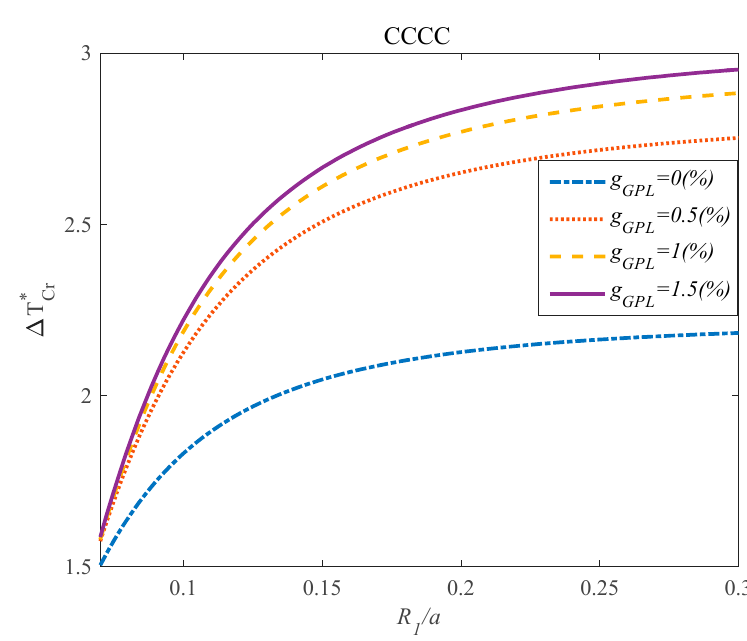
Figure 12. The e ff ects of g_GPL and R_1 / a on the critical temperature of a GPLRC panel for the CCCC Figure 12. The effects of g_GPL and R_1/a on the critical temperature of a GPLRC panel for the CCCC boundary conditions (b / a = 4, h = a / 10, NL = 10, R2 = 5b, µ = h / 10, l = h / 5, and boundary conditions (b/a = 4, h = a/10, NL = 10, R2 = 5b, μ = h/10, l = h/5, and GPL ‐ O). As expected, 𝑔 (cid:3008)(cid:3017)(cid:3013) plays an important role and has a direct influence on the static behavior of